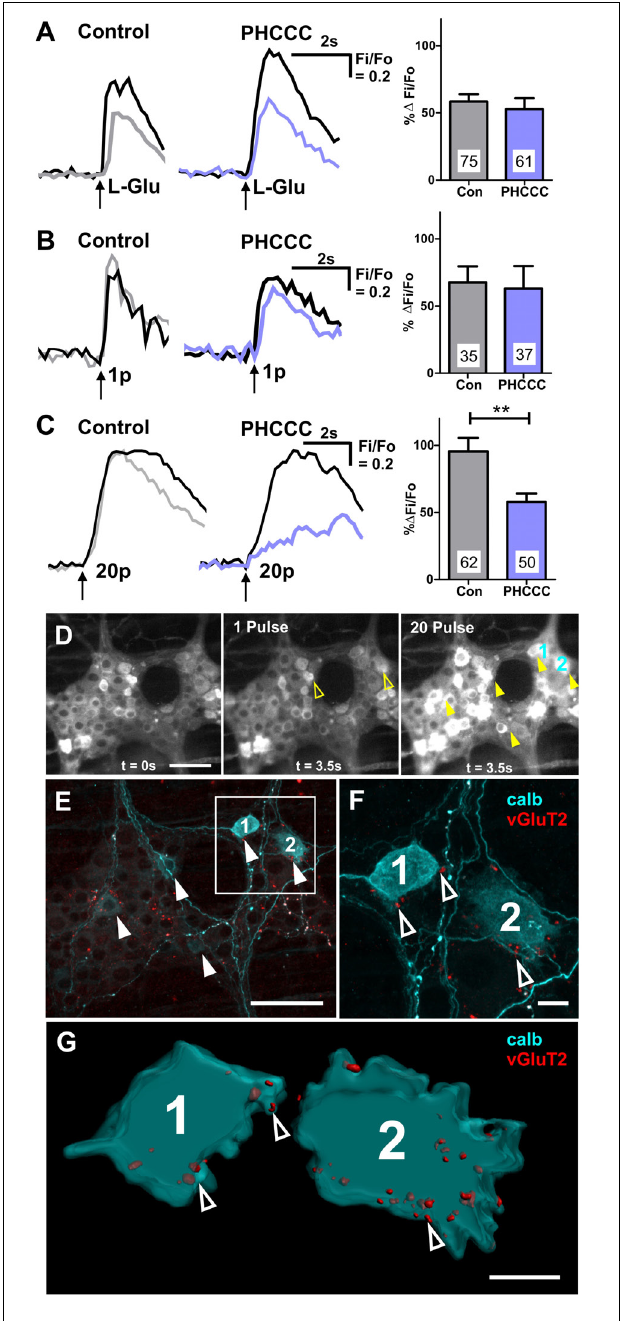
FIGURE 5 | Calbindin+ myenteric neurons receive vGluT2+ varicosities, and exhibit 20 pulse-evoked [Ca 2 + ] i transients that are mediated by Group I mGluRs. Representative traces of [Ca 2 + ] i transients evoked by L -Glu (50 mM) spritz (A) , 1 pulse (B) , and 20 pulse (C) electrical stimulation during time controls (1st stimulation: black trace; 2nd stimulation: gray trace) and PHCCC treatment (control: black trace; PHCCC: purple). Histograms showing pooled [Ca 2 + ] i transient amplitudes from all neurons stimulated with L -Glu (A) , 1 pulse (B) , and 20 pulse (C) in time control (con) and in the presence of PHCCC. Changes in amplitude after application PHCCC are presented as a percentage of the first response in control saline (% (cid:49) F i / F 0 ). Numbers on bar graphs indicate the number of neurons examined. PHCCC significantly